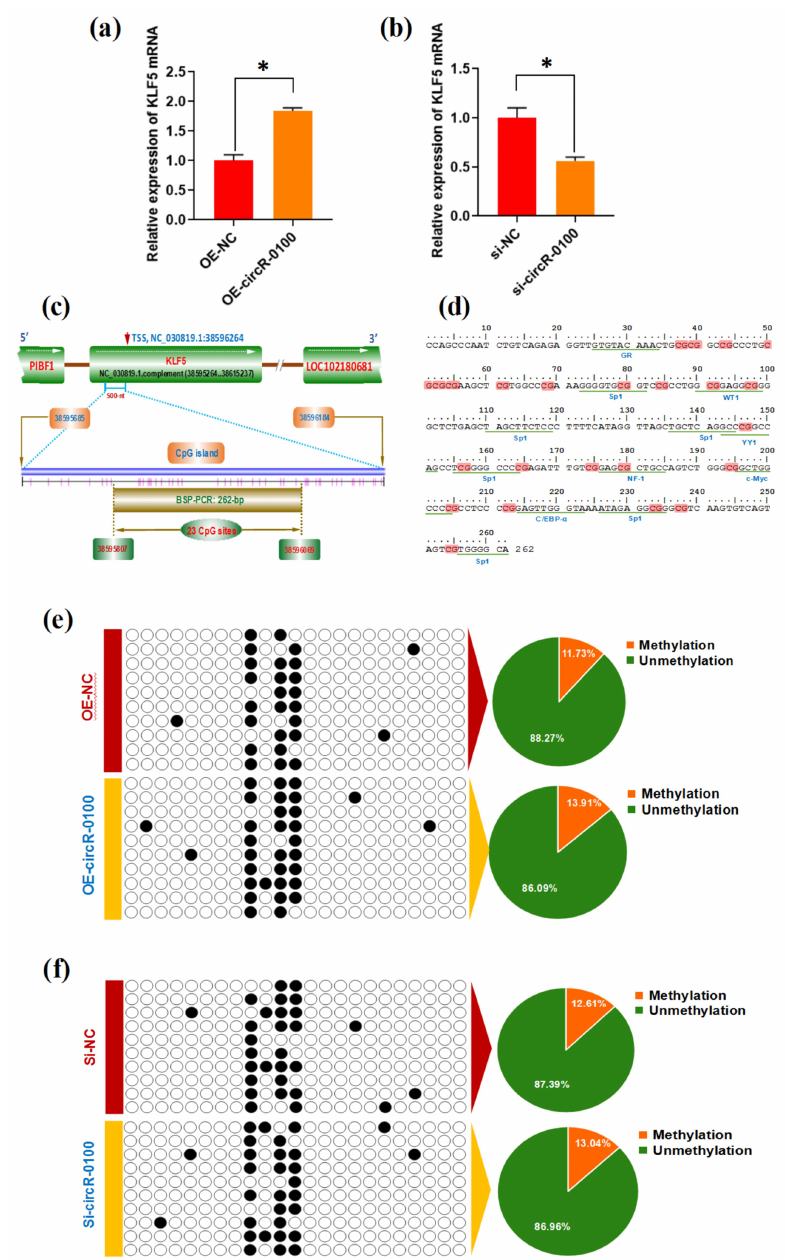
Figure 4. Effects of circRNA-0100 on KLF5 expression and the methylation degree of its promoter in SHF-SCs. (a) Detecting results of KLF5 mRNA in SHF-SCs subjected to treatment with the circRNA-0100 overexpression assay. (b) Detecting results of KLF5 mRNA in SHF-SCs subjected to treatment with the circRNA-0100 knockdown assay. ∗ represents a significant difference ( P< 0 . 05). (c) A diagram of CpG islands in the KLF5 gene promoter region. The nucleotide positions on the Wnt3a gene are indicated by the NC_030819.1 sequence of the goat genome at NCBI (https://www.ncbi.nlm.nih.gov/genome/?term=goat, last access: 17 April 2021). The CpG sites are represented by short pink vertical lines. (d) Potential binding sites of corresponding transcription factors were underlined within the BSP amplification fragment of the KLF5 promoter of goats, and the CpG sites are indicated in shading with dark red. (e) Methylation detecting results of the KLF5 promoter in SHF-SCs subjected to treatment with the circRNA-0100 overexpression assay. (f) Methylation detecting results of SHF-SCs subjected to treatment with the circRNA-0100 knockdown assay. A total of 23 CpG sites were detected in an amplified fragment 262bp in length, with 10 clones sequenced for each group. The obtained results are provided in a line for each clone. The filled black circles indicate the methylated CpG sites, and the unfilled white circles indicate the unmethylated CpG sites. Methylation percentage of different SHF-SCs groups is indicated by pie charts. OE-NC: negative control group, OE-circR-0100: overexpression circRNA-0100 groups, si-NC: negative control group, and si-circR-0100: knockdown group of circRNA-0100. Arch. Anim. Breed., 65, 55–67, 2022